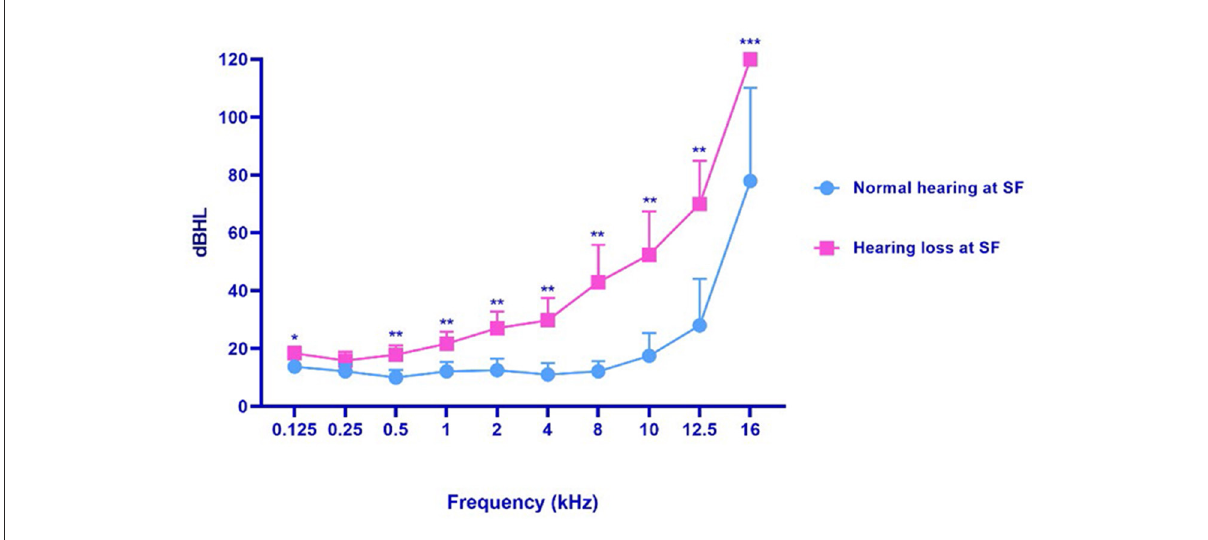
FIGURE2 The hearing threshold of patients with SF normal hearing and patients with SF hearing loss. VM, vestibular migraine, including definite and probable vestibular migraine. SF, standard frequency (0.125–8kHz). * p < 0.05, ** p < 0.01; *** p < 0.001.